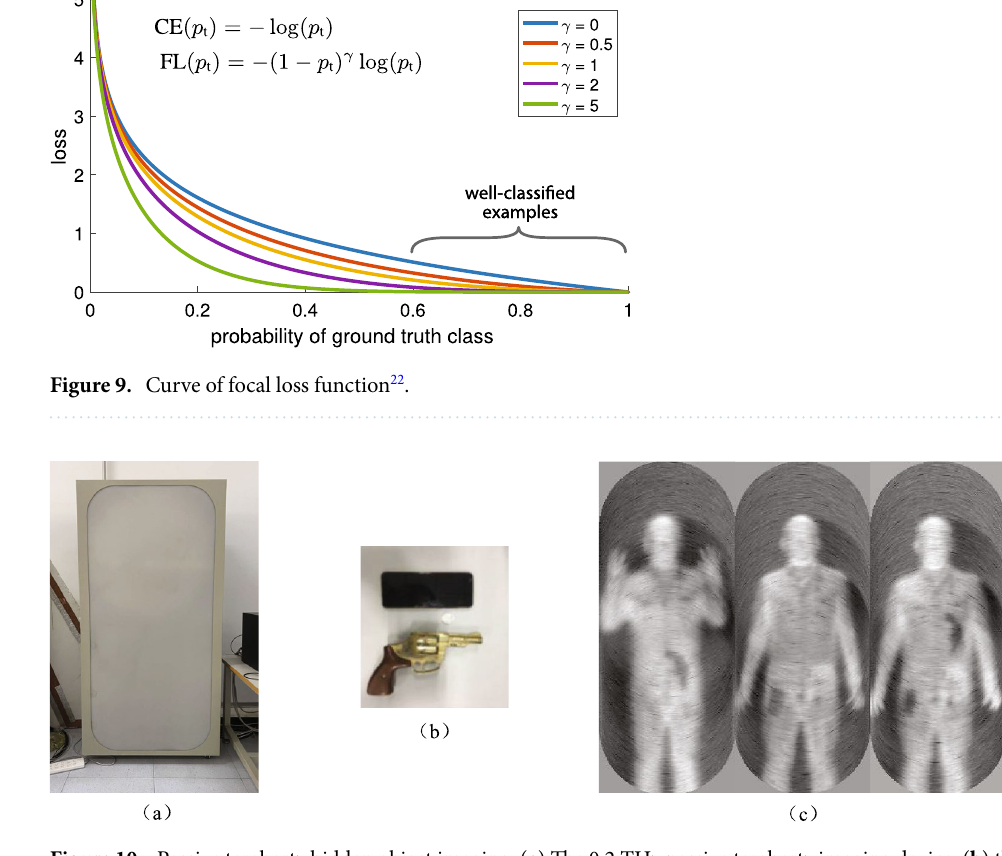
Figure 10. Passive terahertz hidden object imaging. ( a ) The 0.2 THz passive terahertz imaging device. ( b ) the metal pistol model and the mobile phone model. ( c ) the passive terahertz imaging